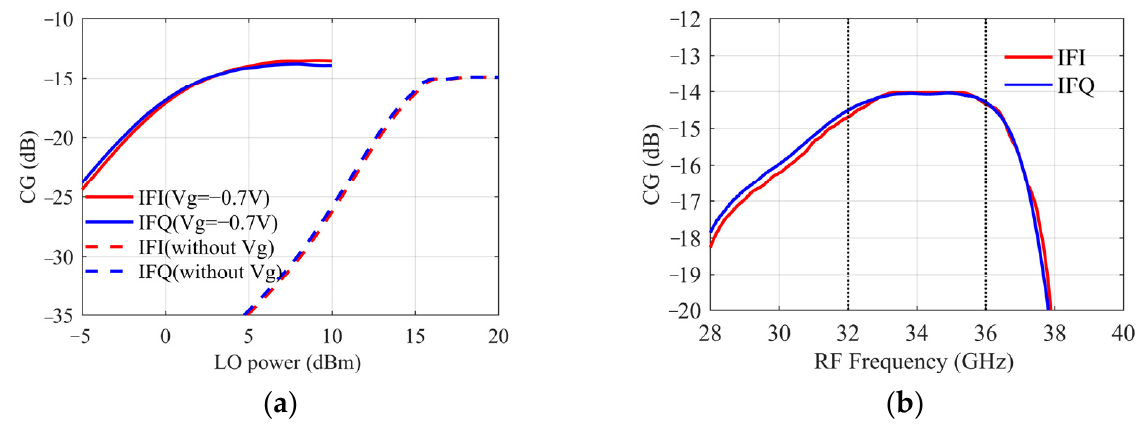
Figure 10. ( a ) Simulation result of conversion gain vs. LO power. ( b ) Simulation result of conversion gain vs. RF frequency.